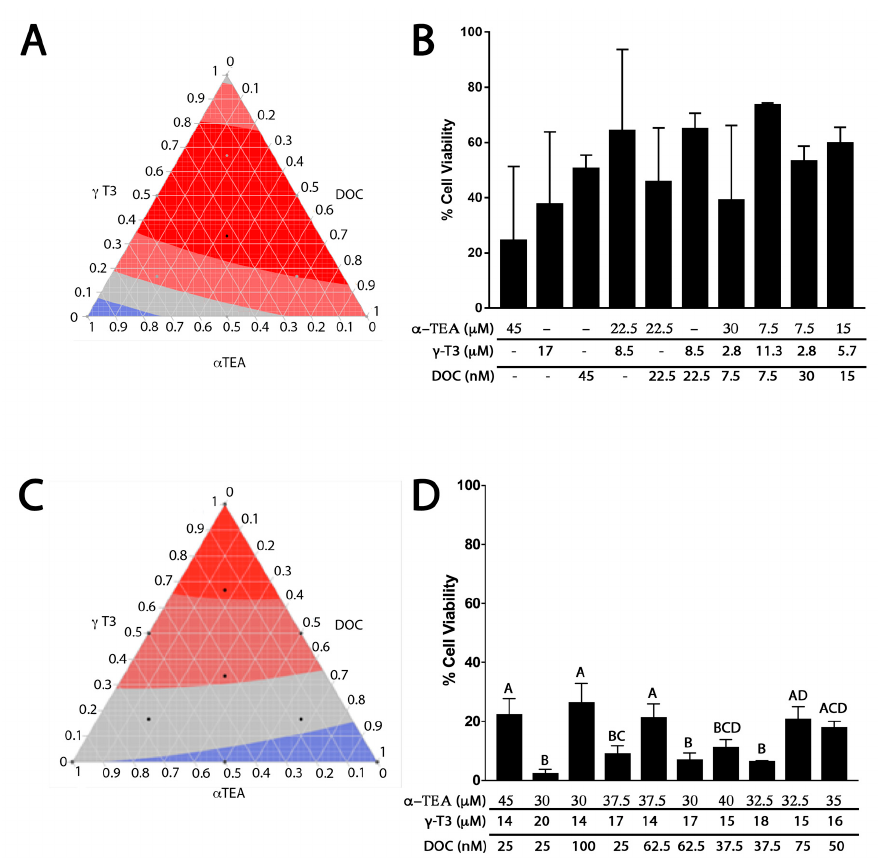
Figure 2. Analysis of γ -T3, α -TEA, and docetaxel (DOC) treatment combinations in PC-3 cells. Black dots on the ternary plots represent points where data were collected to produce the mixture design response surface methodology (MDRSM). Bright red areas represent the most e ff ective combinations for reducing cell viability. Deep red, gray, and blue areas represent decreasing levels of e ff ectiveness in descending order. ( A ) Ternary plot displaying MDRSM analysis conducted with the vertices corresponding to each of the three compounds at their respective IC 50 values. ( B ) Bar graph displaying cell viability data used to generate ternary plot A. The data were highly variable and only treatment with 45 µ M α -TEA was observed to be significantly di ff erent from control ( p = 0.0390). No statistical di ff erences reported among any of the other compounds / mixtures. ( C ) Ternary plot displaying MDRSM analysis conducted with the mixture at each vertex containing the lowest dose observed to have maximal e ff ect for one compound, and the highest concentrations of the other two compounds that elicited no e ff ect ( γ -T3 low: 14 µ M, high: 20 µ M; α -TEA low: 30 µ M, high: 45 µ M; and DOC low: 25 nM, high: 100 nM). ( D ) Bar graph displaying cell viability data used to generate ternary plot B. The most e ff ective combination for reducing cell viability (combination 2; 97.53% reduction relative to control ( p < 0.0001) consisted of 30 µ M α -TEA, 20 µ M γ -T3, and 25 nm DOC, though this result was not significantly di ff erent from combinations 4 (90.77%), 6 (92.92%), 7 (88.69%), or 8 (93.42%). Several combinations containing higher concentrations of VE compounds with lower concentrations of DOC were associated with significantly greater reduction in cell viability compared to mixtures containing higher concentrations of DOC with lower concentrations of vitamin E (VE) compounds. Specifically, this result was observed for combinations 6 ( p < 0.0001), 7 ( p = 0.0007), and 8 ( p < 0.0001), which contained 62.5, 37.5, and 37.5 nM DOC respectively, compared to combination 3 (73.47% reduction), which contained 100 nM